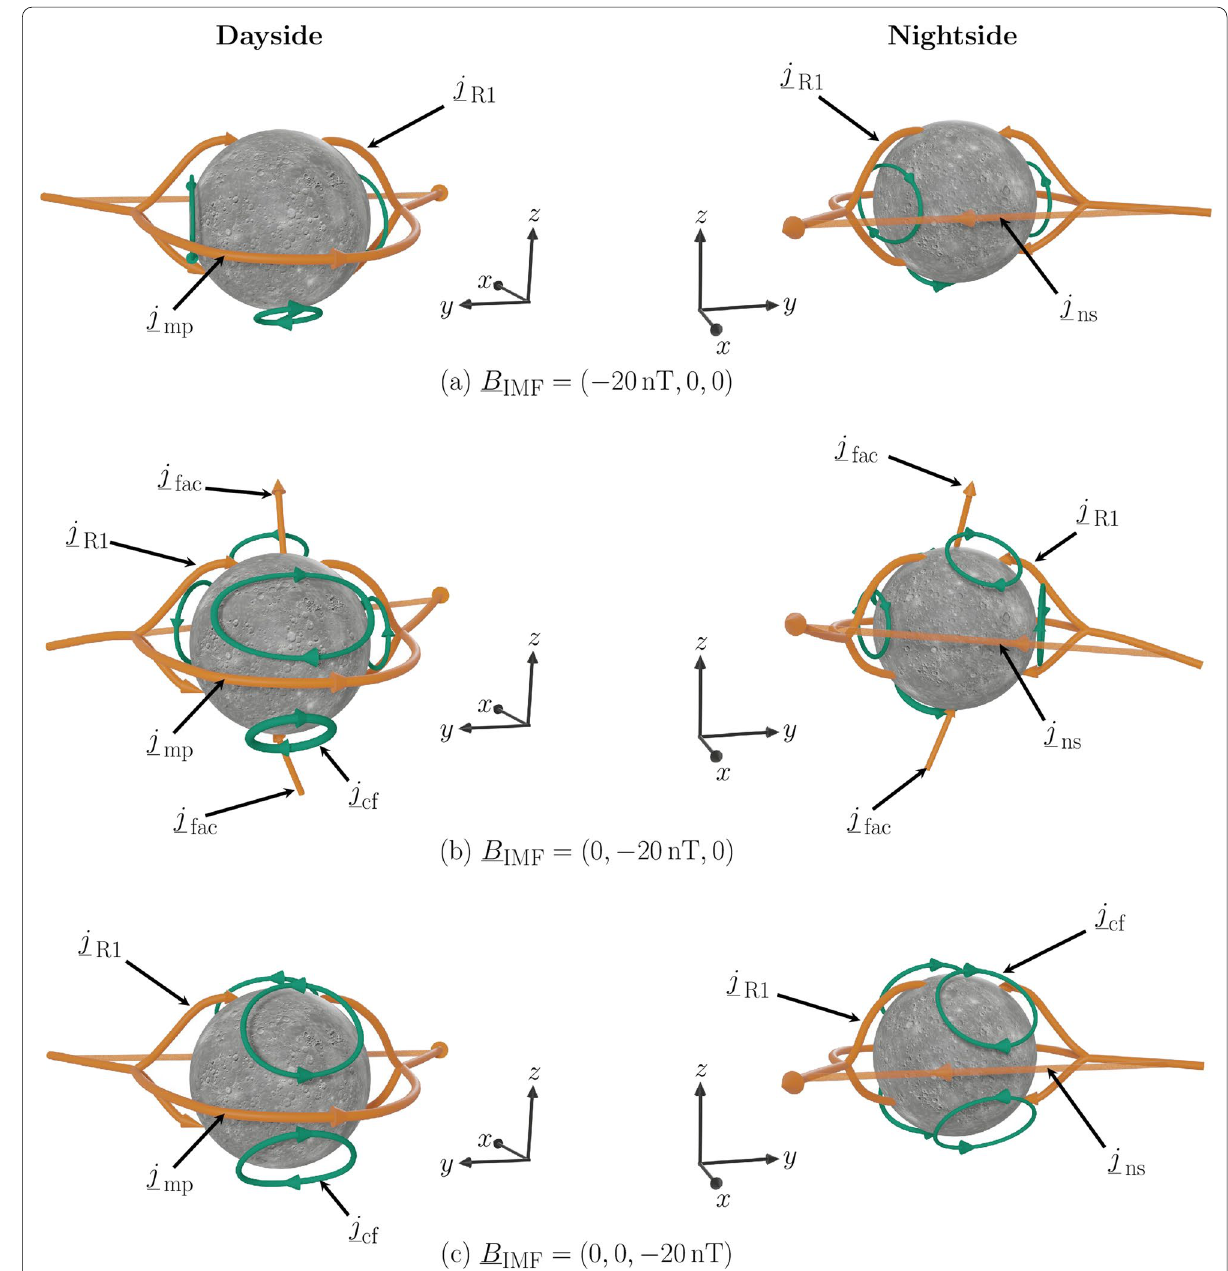
Fig. 5 Sketch of the poloidal (orange) and toroidal (green) currents under negative B IMF with various orientations in the MASO coordinate